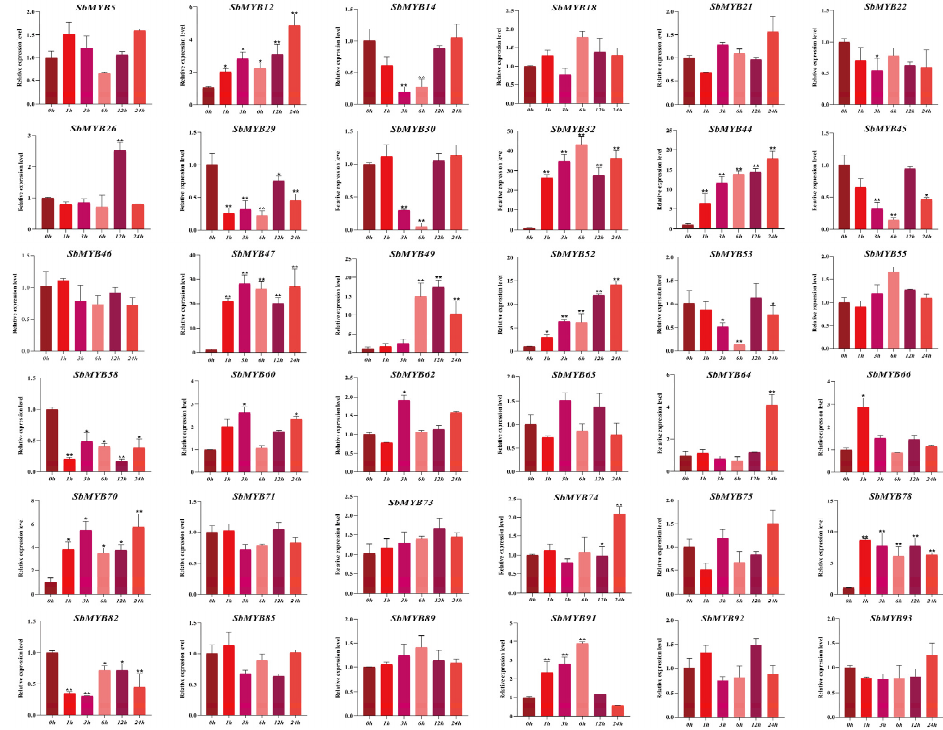
Figure 10. Response to PEG6000 treatments of 36 selected R2R3-SbMYB genes. The reference gene was SbACT7. Comparing the experimental and control groups (0 h), statistically significant differences are indicated by * p < 0.05, ** p < 0.01.